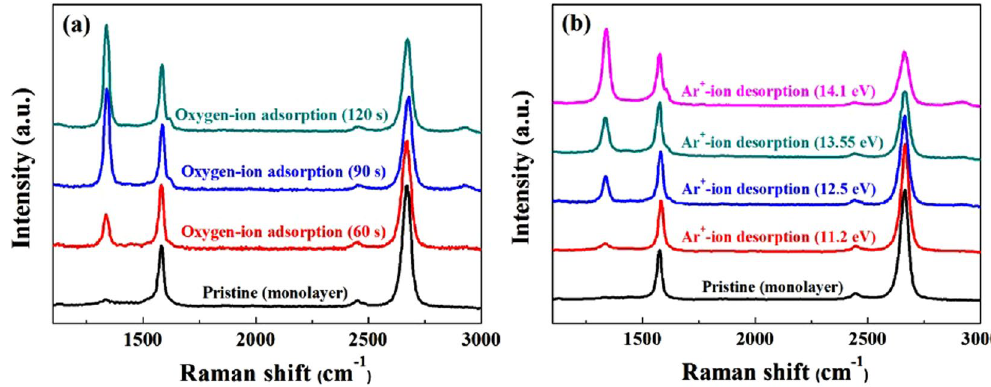
Figure 3. Raman spectra of monolayer graphene to different oxygen-ion adsorption time and Ar + -ion energies. ( a ) Monolayer graphene after exposure to an optimize the oxygen-ion condition for different chemical adsorption time and ( b ) monolayer graphene after exposure to different Ar + -ion energies. For comparision, Raman spectrum of pristine monolayer graphene was